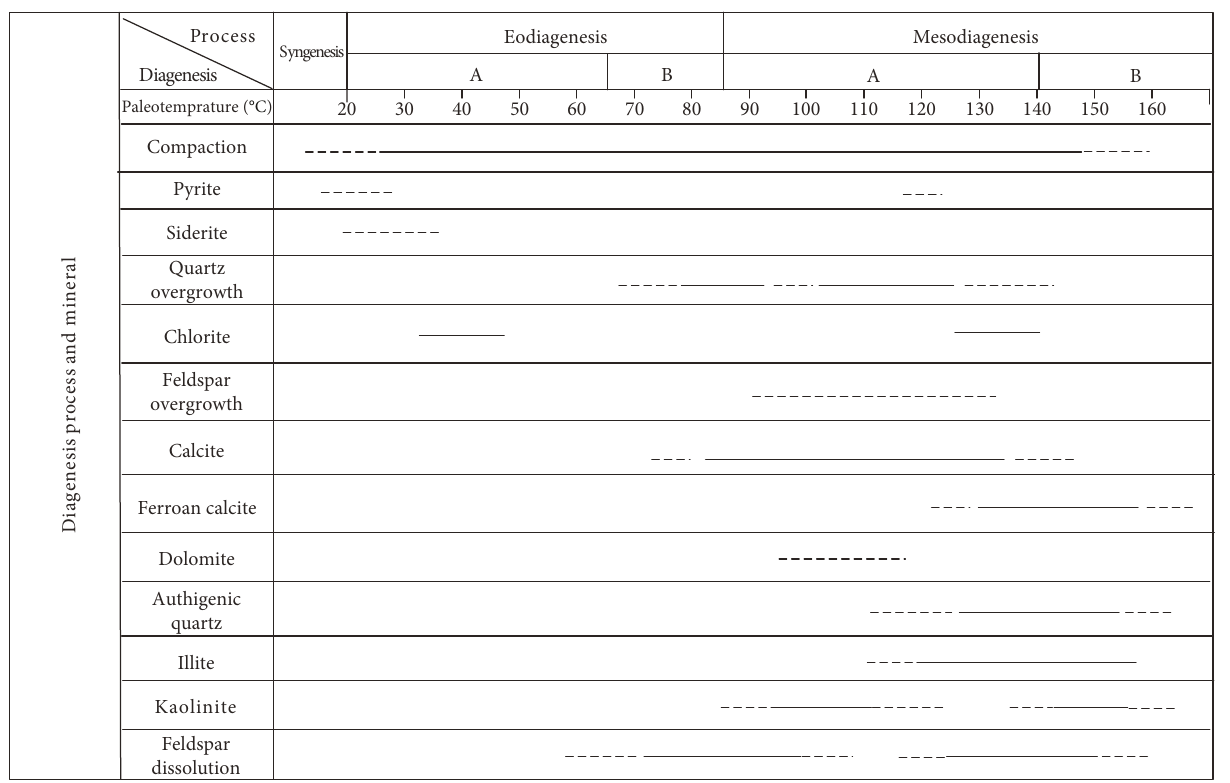
Figure 13: Diagenetic sequence and pore evolution model of the sandstone in the He 8, Shan 1, and Shan 2